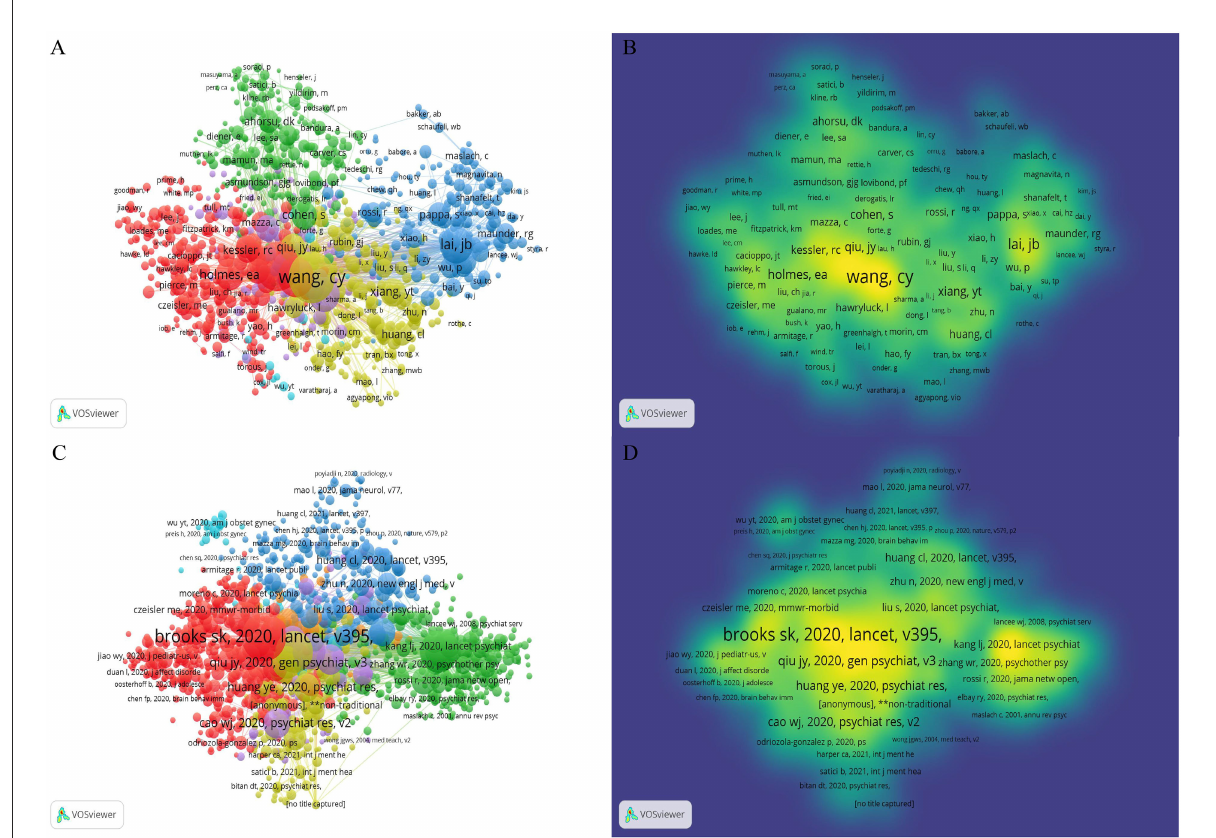
FIGURE4 The co-citation map of authors and references on mental health research related to COVID-19. (A) The network visualization map of co-cited authors and (B) the density visualization map of co-cited authors. (C) The network visualization map of co-cited references and (D) the density visualization map of co-cited